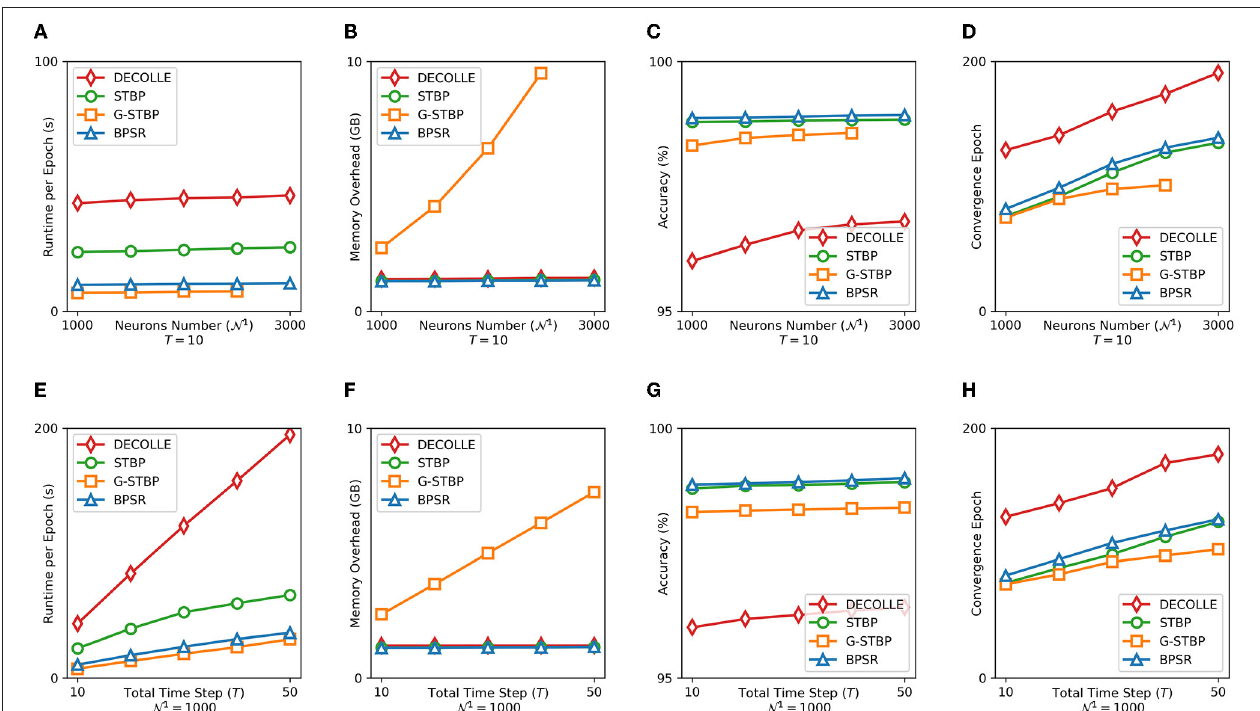
FIGURE 7 | (A) Runtime, (B) graphic memory overhead, (C) accuracy, and (D) convergence epoch of four learning algorithms are counted under the different number of hidden layer neurons N 1 . Panels (E–H) are the corresponding indicator under the different length of time window T .